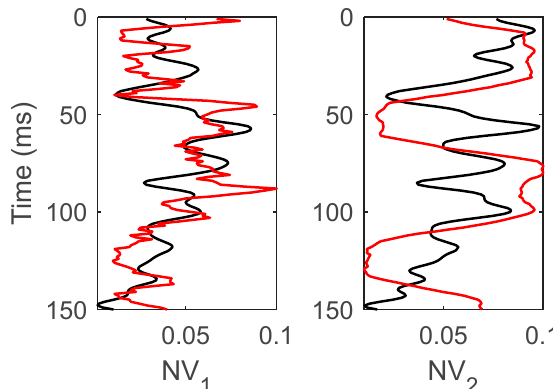
Figure 7. Fracture density (anisotropy intensity multiplied by a factor) obtained through elliptical inversion using synthetic data (Figure 4a).